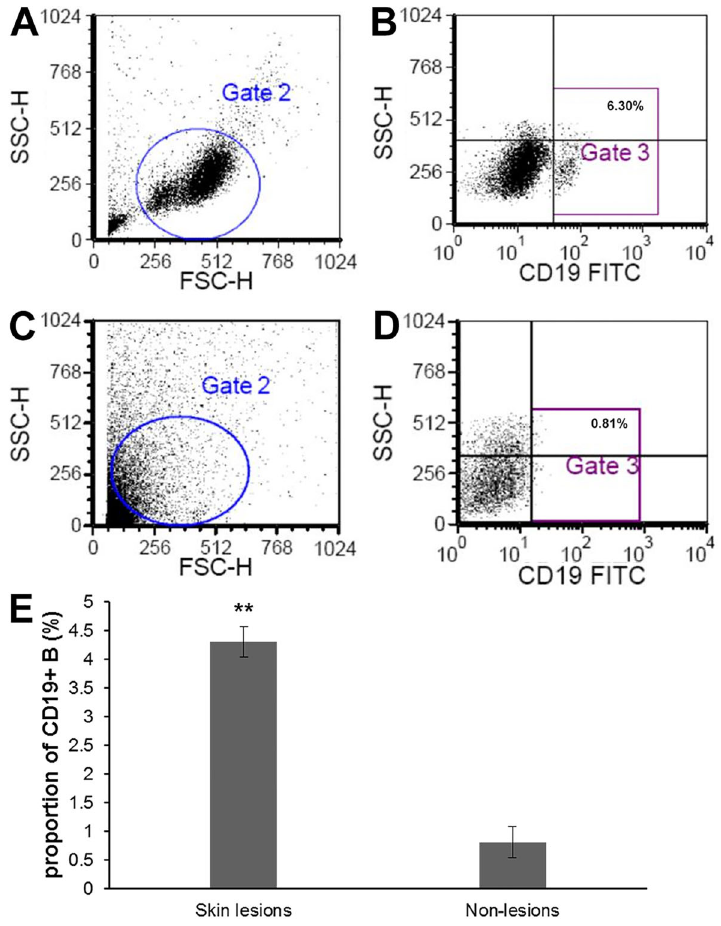
Figure 4. A , total lymphocytes and B , proportion of CD19 + B cells from the skin lesion of a patient with erythrodermic psoriasis (Gate 2 and 3, respectively). C , total lymphocytes and D , propor- tion of CD19 + B cells from a non-lesion area of a patient with erythrodermic psoriasis (Gate 2 and 3, respectively). E , proportion of CD19 + B cells from skin lesions and non-lesion areas of erythrodermic psoriasis patients are shown as means ± SD (n=7 for skin lesions; n=7 for non-lesions). **P o 0.001 vs non-lesions (one-way analysis of